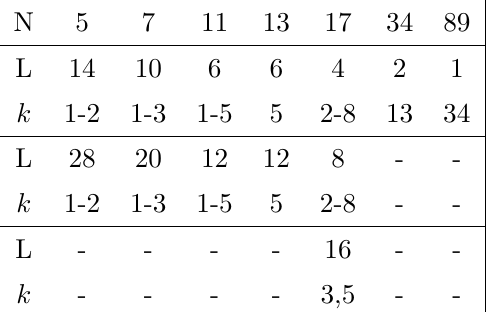
k 1-2 1-3 - k - - - - 3,5 - - Table 1. Values of N , L and k used in the non-perturbative lattice simulations. ratio (cid:12)xed. Comparing the results at di(cid:11)erent values of b and L one can quantify these errors. In our case, they are not expected to a(cid:11)ect the main conclusions of the paper.